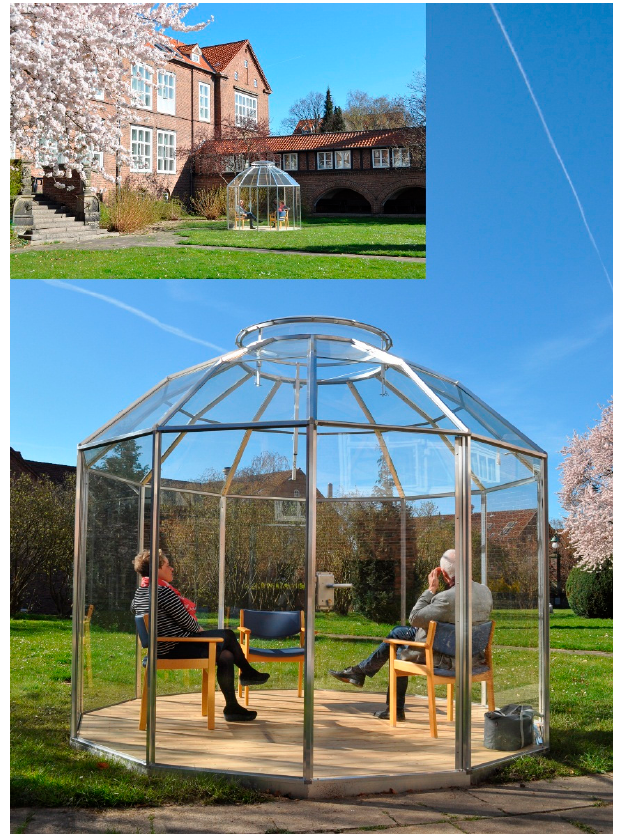
Figure 5. The greenhouse is constructed of one layer window glass with acrylic at the very top.